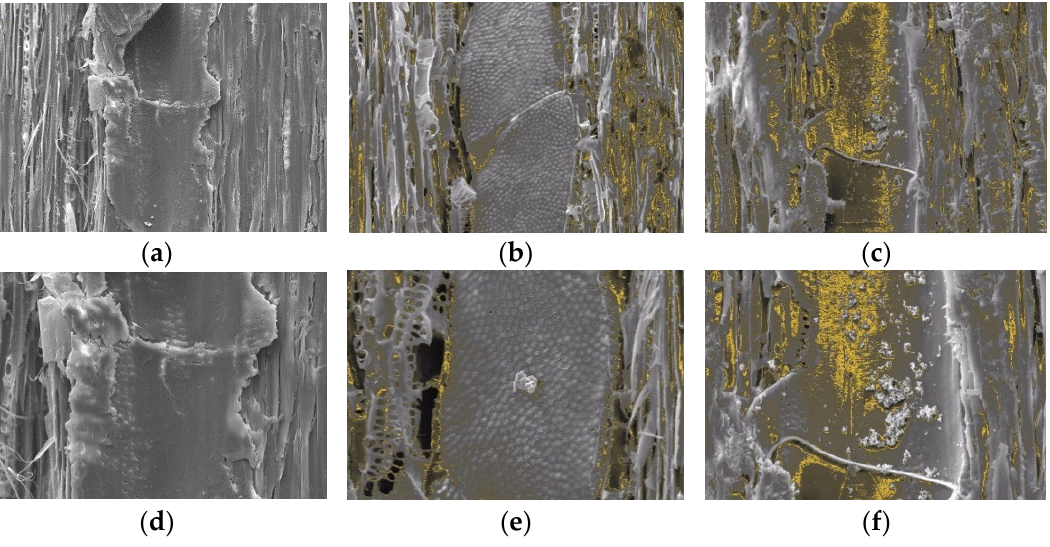
Figure 7. SEM images of untreated mangium wood 500× ( a ), mangium wood impregnated with 1% TiO 2 nanoparticle 500× ( b ) and mangium wood impregnated with 5% TiO 2 nanoparticle 500× ( c ), untreated mangium wood 1000× ( d ), mangium wood impregnated with 1% TiO 2 nanoparticle 1000×, ( e ) and mangium wood impregnated with 5% TiO 2 nanoparticle 1000× ( f ).